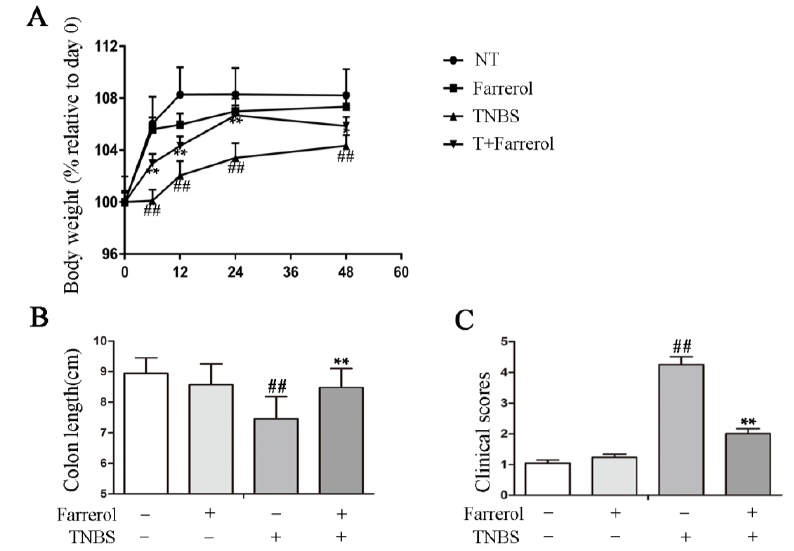
Figure 1. Farrerol ameliorates 2,4,6-trinitrobenzene sulfonic acid (TNBS)-induced colonic inflammation in mice. ( A ) Body weight. Body weights were normalized to body weight on day 0; ( B ) The colon length of mice with different treatment; and ( C ) Clinical score of mice. n = 10, and ## p < 0.01 compared to the control group, ** p < 0.01 compared to the TNBS treatment group-statistical significance was determined by ANOVA.